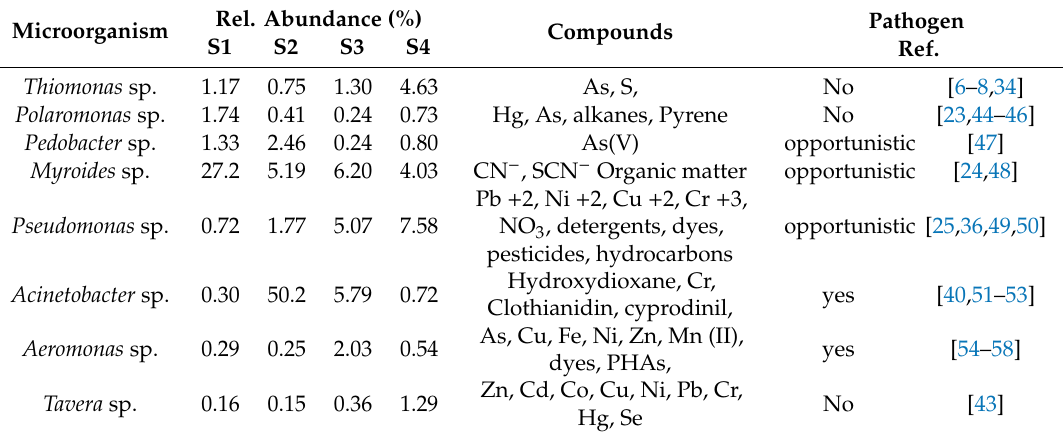
Table 3. Microorganisms with bioremediation potential.